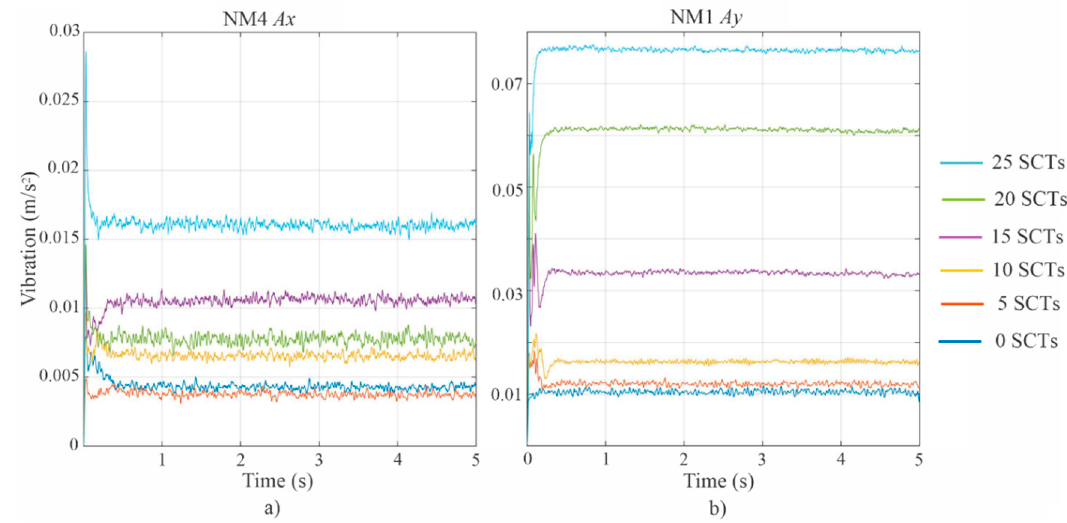
Figure 8. RMS values for all conditions: ( a ) NM4 Ax and ( b ) NM1 Ay.